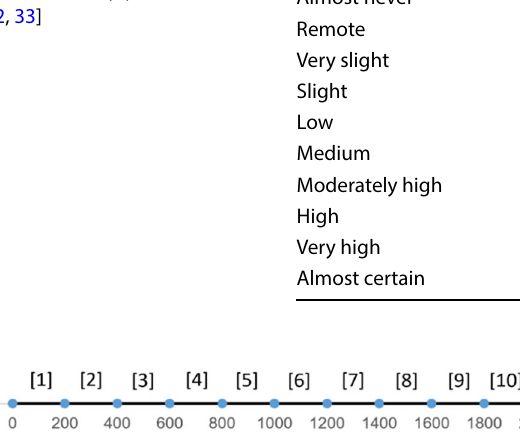
Table 1 FMEA Scale for severity (S), occurrence (O), and detection (D) numbers [32, 33]